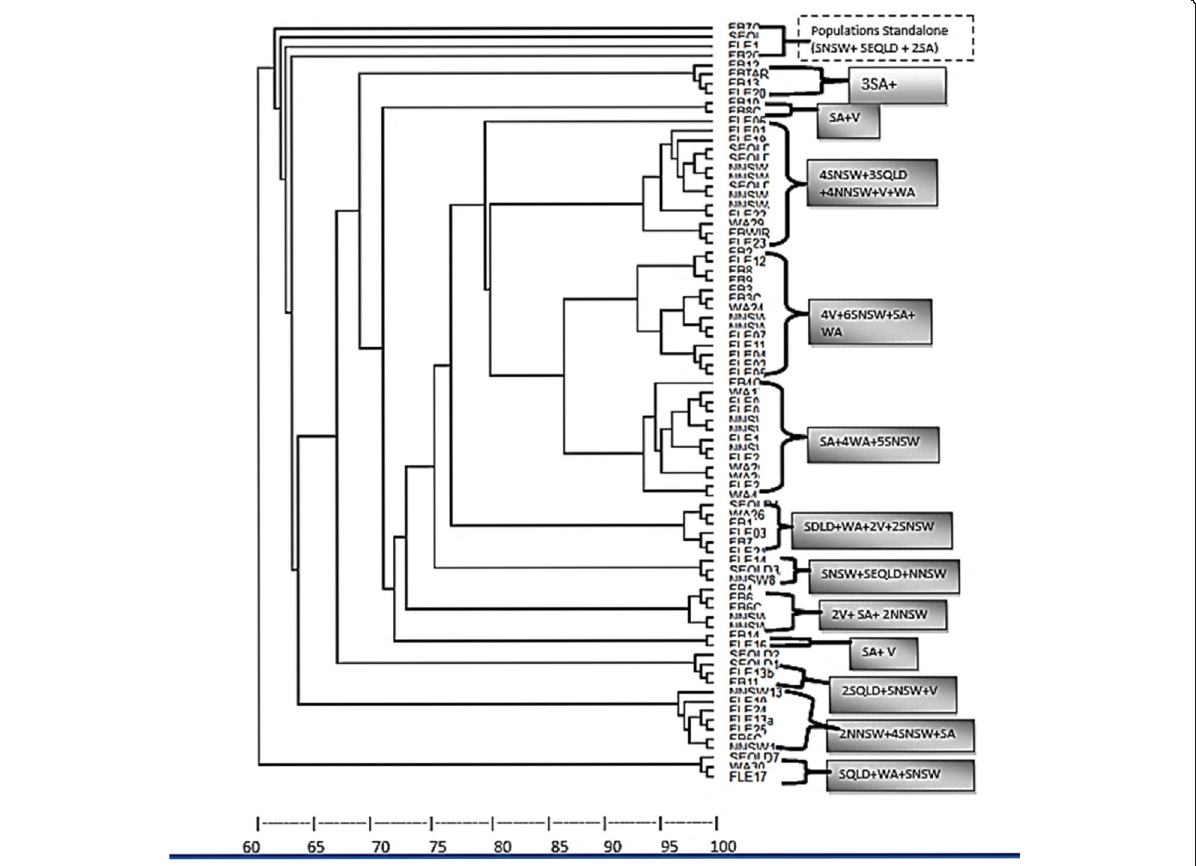
Fig. 2 UPMGA dendrogram shows the relationship among 82 populations of flaxleaf fleabane collected from different locations across Australia for the between population study . White clusters represent populations sourced from one location (standalone), and gray clusters represent populations sourced from different